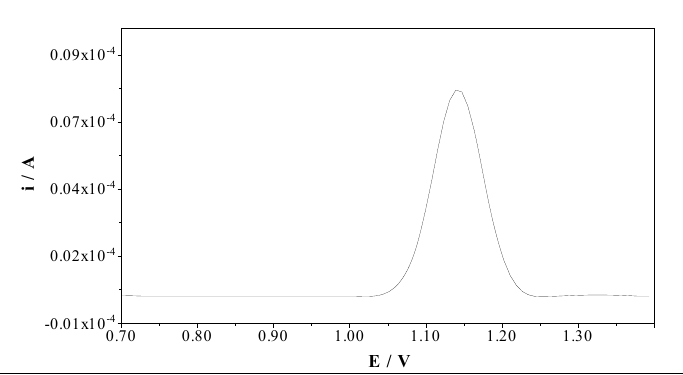
Figure 11. Differential pulse voltammogram of template by PGE in a desorption